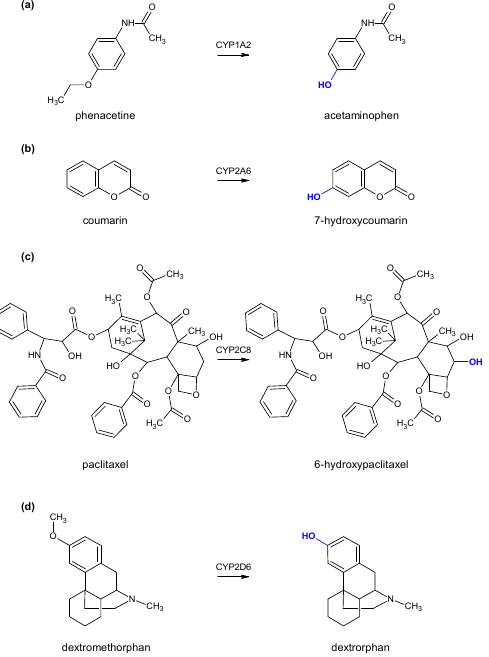
Figure 2. Marker substrates and reactions used for monitoring enzyme activity: ( a ) Phenacetin O - deethylation for the CYP1A2 enzyme, ( b ) coumarin 7-hydroxylation for the CYP2A6 enzyme, ( c ) paclitaxel 6- α -hydroxylation for the CYP2C8 enzyme, and ( d ) dextromethorphan O -demethylation for the CYP2D6 enzyme. The sites of reaction are marked in blue.